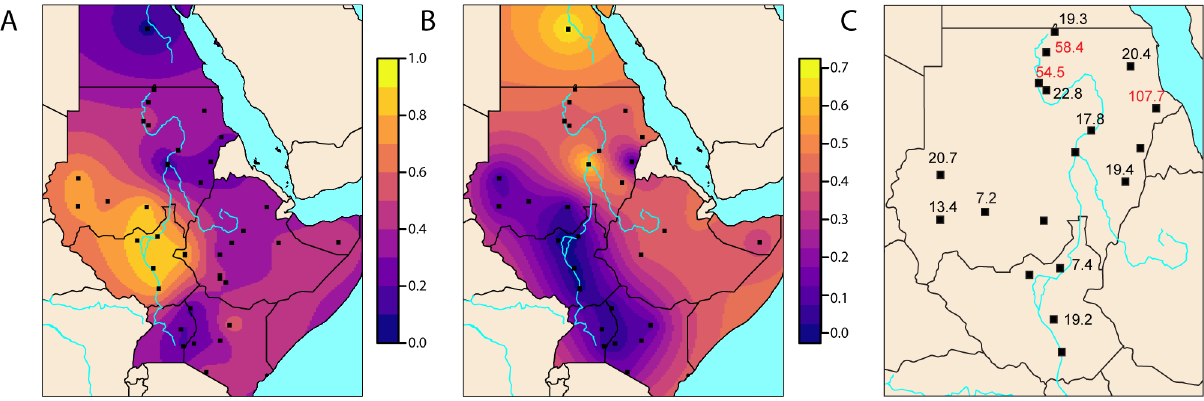
Fig 3. Maps showing the amount of Nilotic and Eurasian admixture and admixture dates in investigated populations. (A) Map shows the distributionof the Nilotic componentin Northeast African populations(at K = 7). (B) Estimated non-African(using a Europeangroup) admixtureusing f 4 -ratios (see Methods). (C) Admixture dates (in generations) of Sudanese populationsestimated using patterns of LD decay [34]. Numbers in red indicatemultiple admixtureevents of which the oldest is shown. Populations without admixturedates had no significant results in the analysesfor an admixtureevent betweena Sudaneseor South Sudanese populationand a non-Africanpopulation. See S7 Table for putative admixturesources.